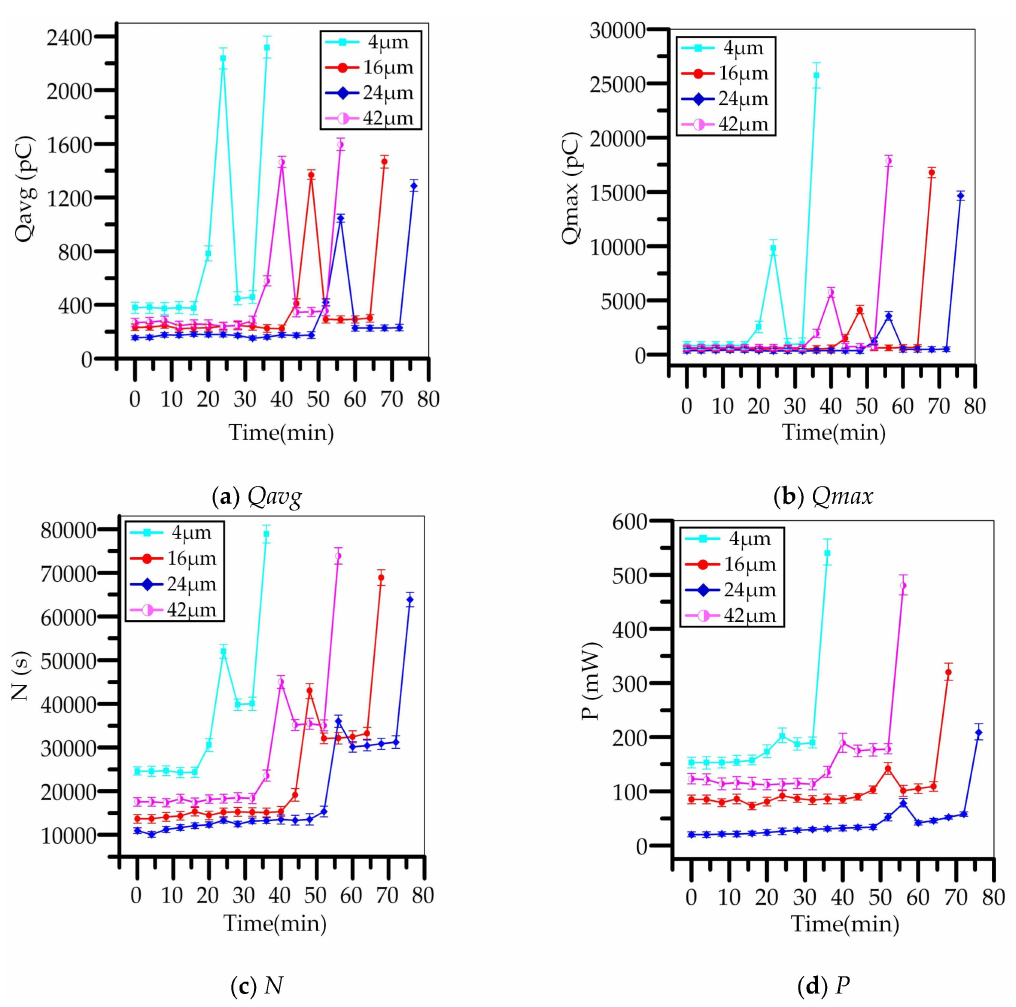
Figure 5. The time trend of PD parameters under different